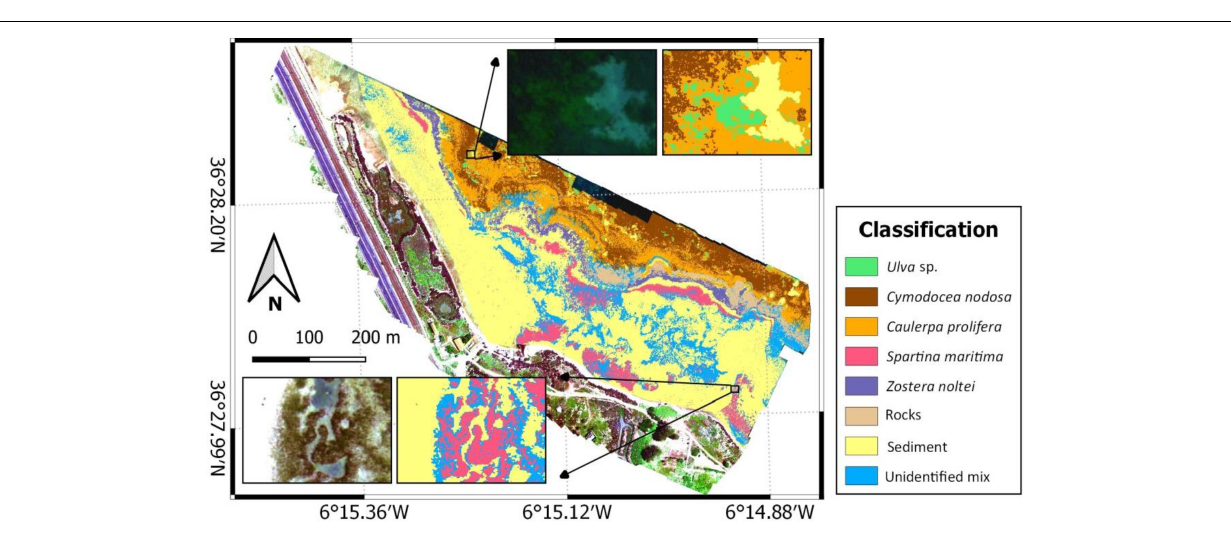
FIGURE 6 | Minimum distance classifier, trained using image-derived spectra, result from the multispectral UAV survey in the study area. Coordinates are in WGS84 (EPSG: